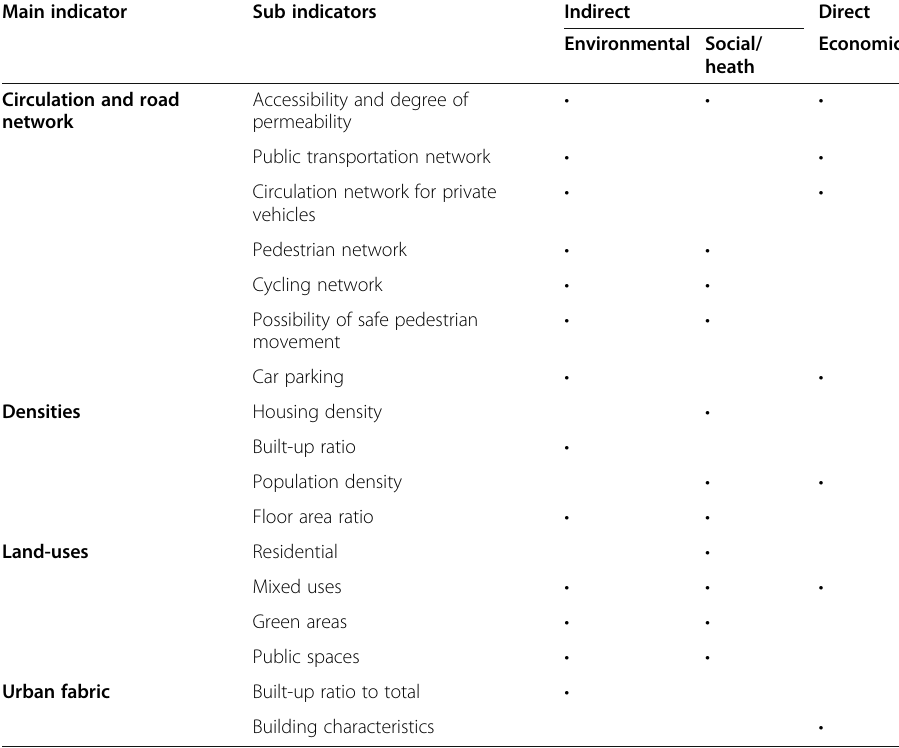
Table 2 Linking the urban form with economic suitability Main indicator Sub